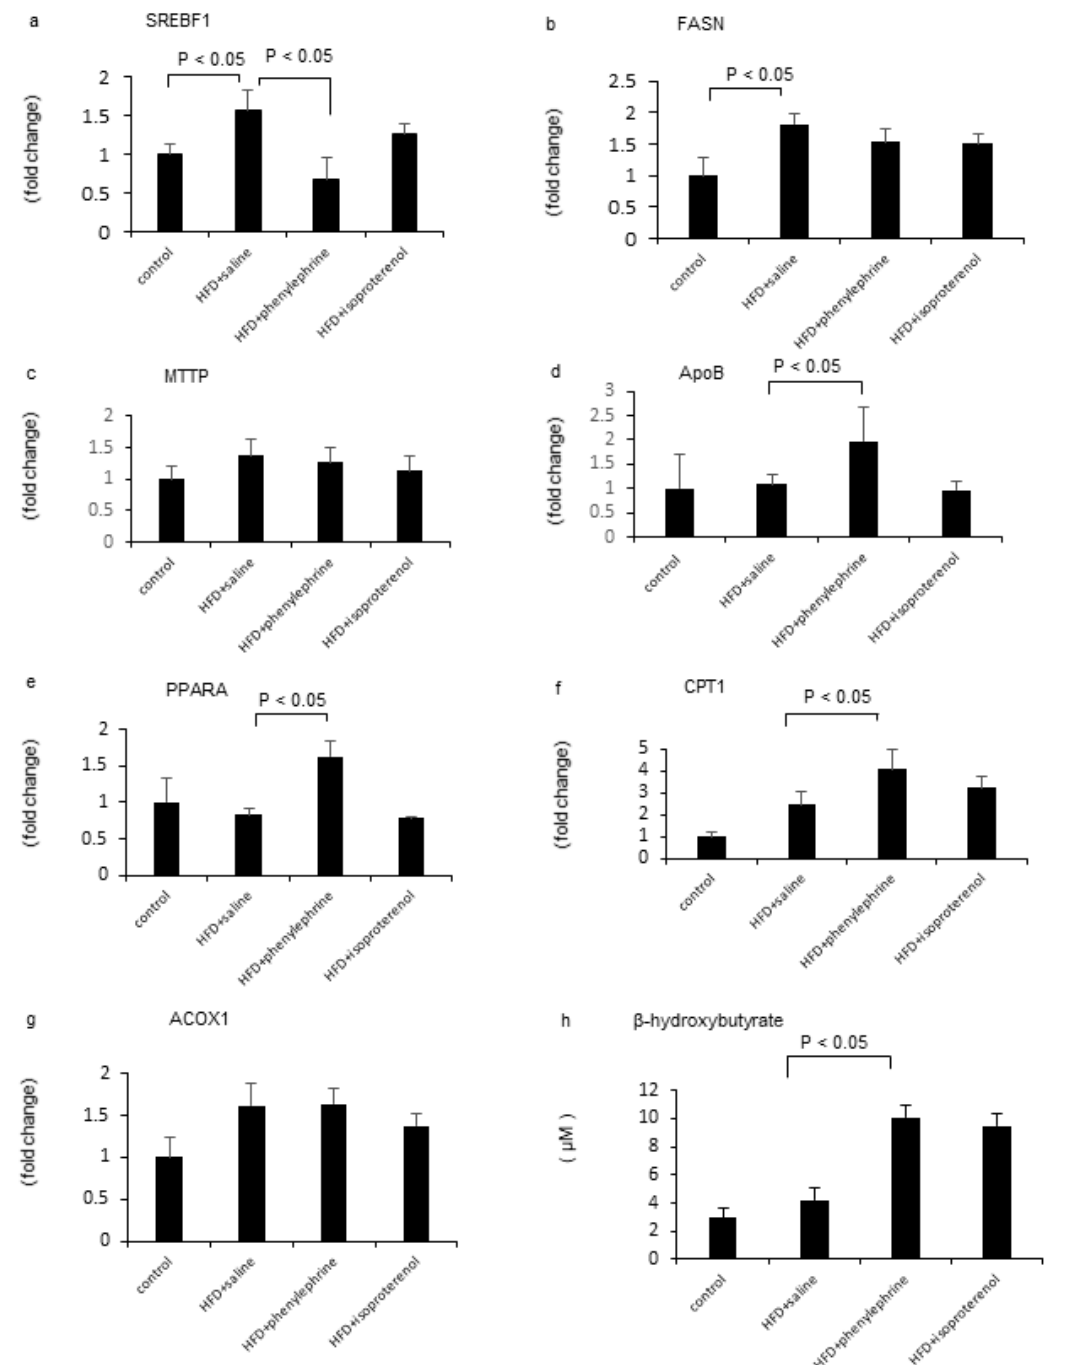
Figure 2. Evaluation of hepatic lipid metabolism-related genes. Relative mRNA expression levels of SREBF1 ( a ), FASN ( b ), MTTP ( c ), ApoB ( d ), PPAR α ( e ), CPT1 ( f ), and ACOX1 ( g ) were evaluated. Hepatic β -hydroxybutyrate contents were evaluated using ELISA ( h ). Statistical analysis was performed using ANOVA. Data are expressed as means ± SE.